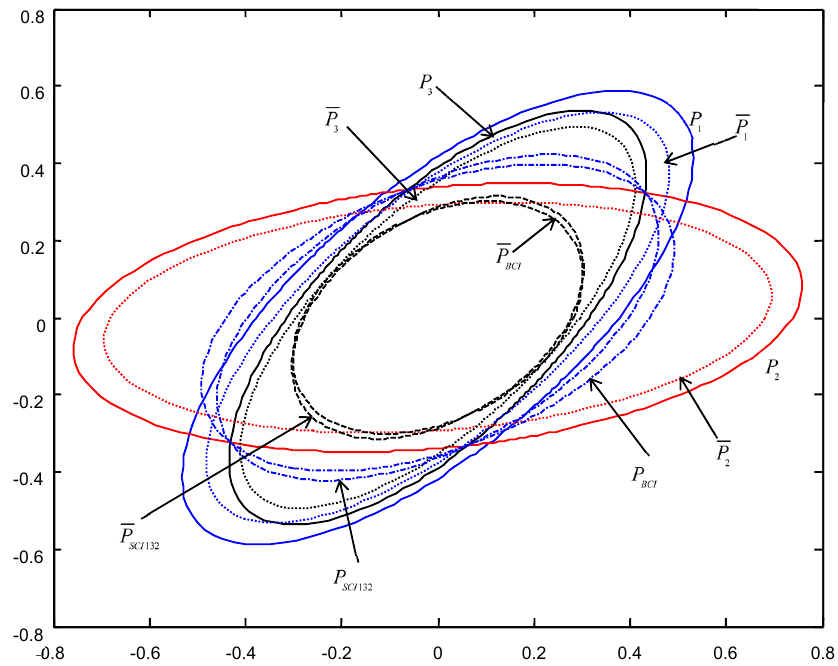
Figure 6. The ellipses of the actual and conservative time-varying filtering error variances of the order SCI 132 at t = 10.